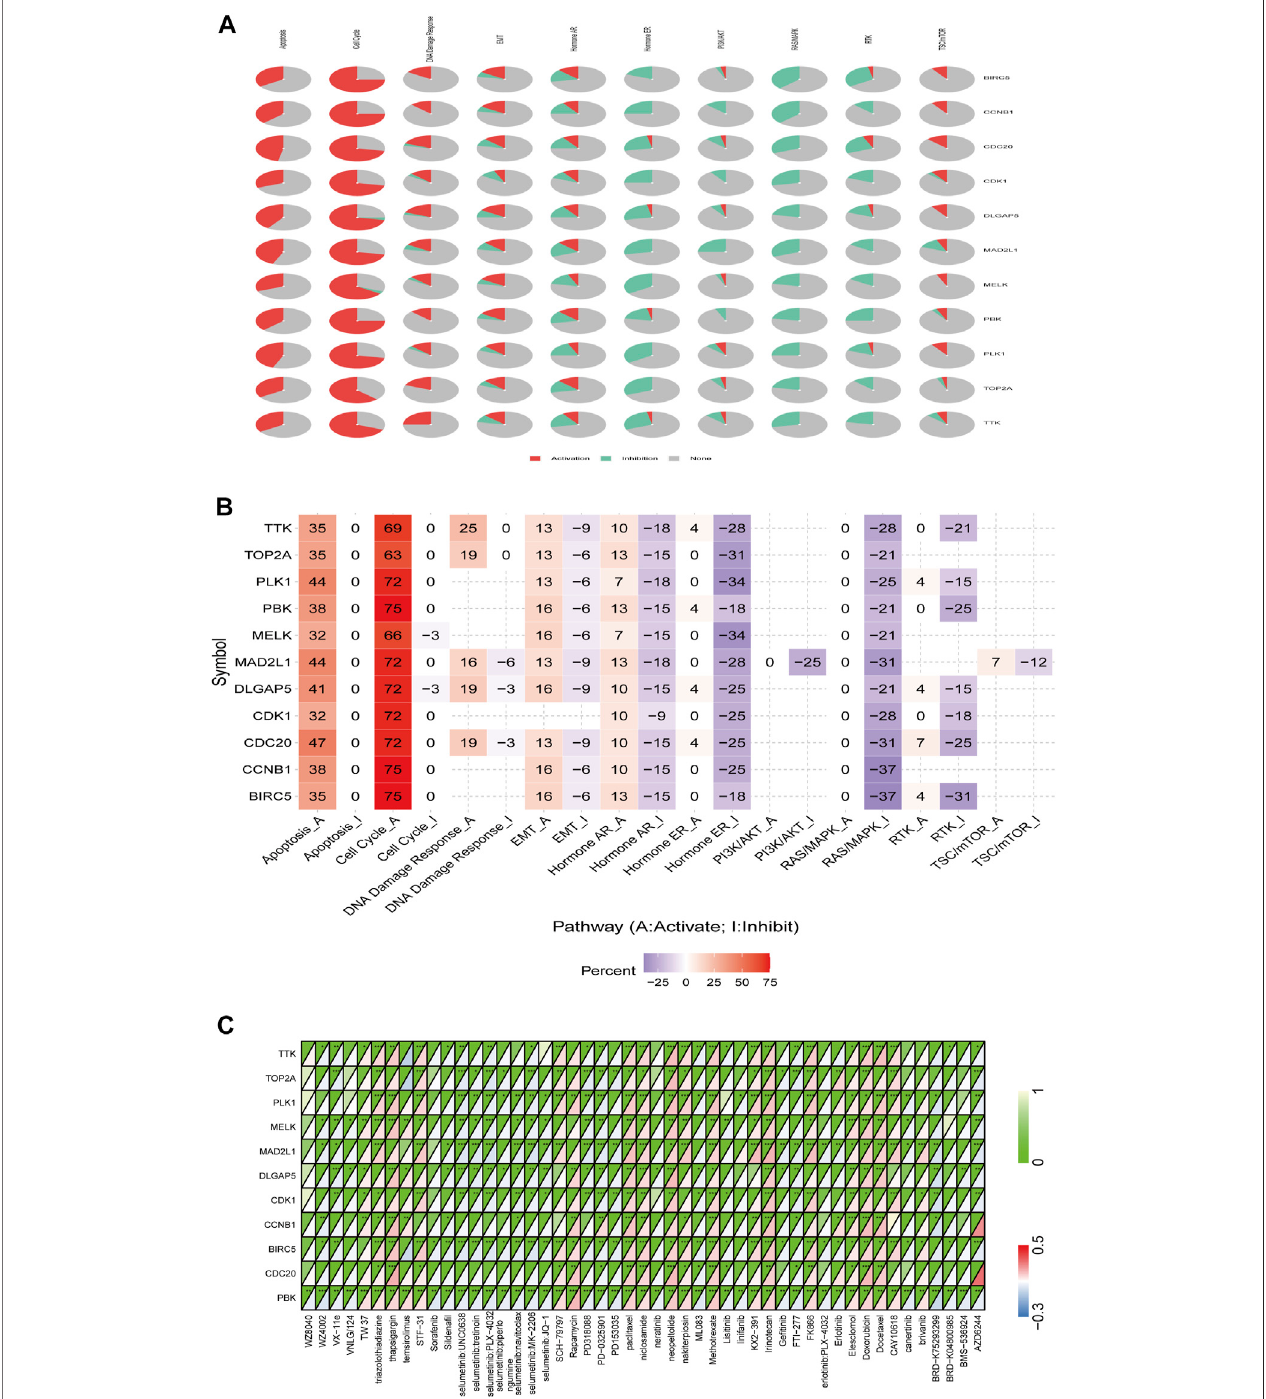
FIGURE 9 | Role of PBK in known cancer-related pathways (GSCALite) and analysis of drugs potentially targeting PBK based on PharmacoDB data. (A, B) Pie chart (A) and heatmap (B) of pathway activity. (C) Heatmap of drugs correlated with 10 genes (BIRC5, CCNB1, CDC20, CDK1, DLGAP5, MAD2L1, MELK, PLK1, TOP2A, and TTK) and